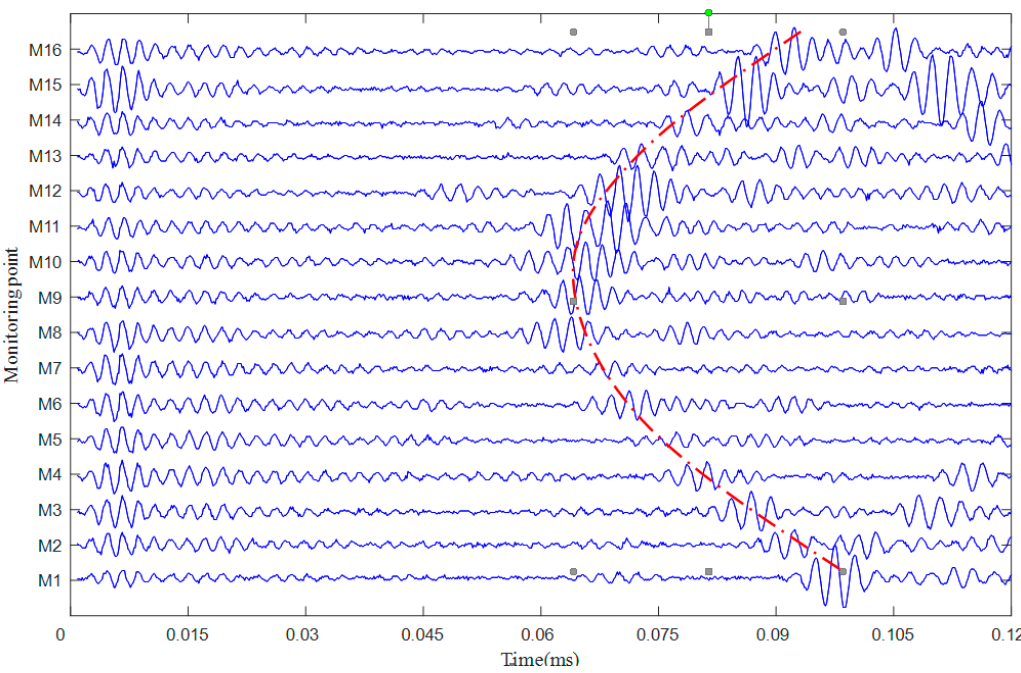
Figure 11. The monitoring signal excited at sensor E9.